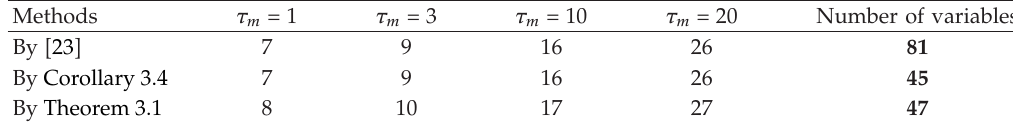
(cid:3) for given τ M m .